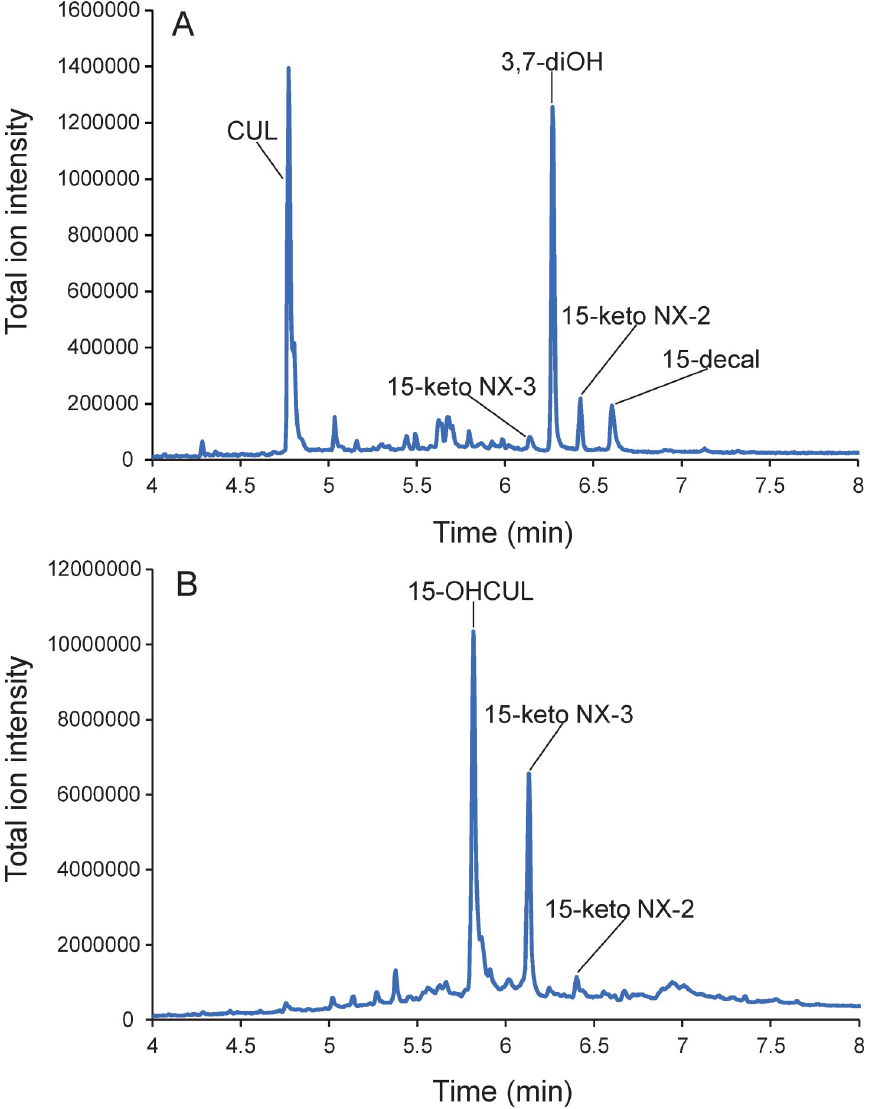
Fig 2. GC-MS analysis of toxic secondary metabolites in vitro. (A) Five toxins were detected in agmatine broth cultures of NRRL 66927 F . sp. nov.-16, including the sesquiterpene culmorin (CUL) and four type A trichothecenes. Two of the latter, 7-hydroxy isotrichodermol (3,7-diOH) and 15-decalonectrin (15-decal), were previously known; however, 15-keto NX-2 and its deacetylated form 15-keto NX-3 were first discovered and characterized here. (B) The novel type A trichothecenes 15-keto NX-2 and 15-keto NX-3 were detected in a rice culture of NRRL 66921 F . sp. nov.- 15, together with 15-hydroxy culmorin (15-OHCUL). entire wheat head. Some of these strains exhibited levels of aggressiveness like the highly aggressive positive control NRRL 31084 F . graminearum (S3 Table, Fig 3). Strains of F . sp. nov.-15 and -16, the two novel species within the Sambucinum Clade that produced 15-keto NX-2 and 15-keto NX-3 along with other toxins in culture, induced bleaching on Apogee and spread, causing considerable disease above and below the inoculation point (S4 Table, Fig 3). Variation in aggressiveness was noted among strains tested within the Graminearum Clade (S4 Table, Fig 3). NIV-producing species within this Clade ( F . austroamericanum , F . cerealis , F . cortaderiae , F . meridionale , and F . praegraminearum ) displayed moderate (43–64%, Fig 3)